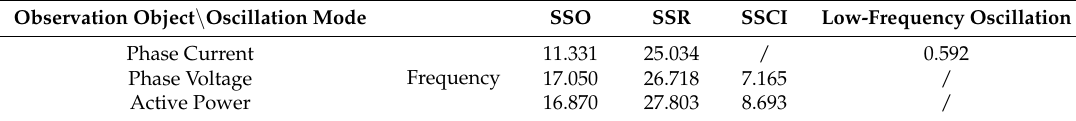
Table 7. Analysis of Oscillation Mode of Wind Turbine on Actual Phase Current, Phase voltage and